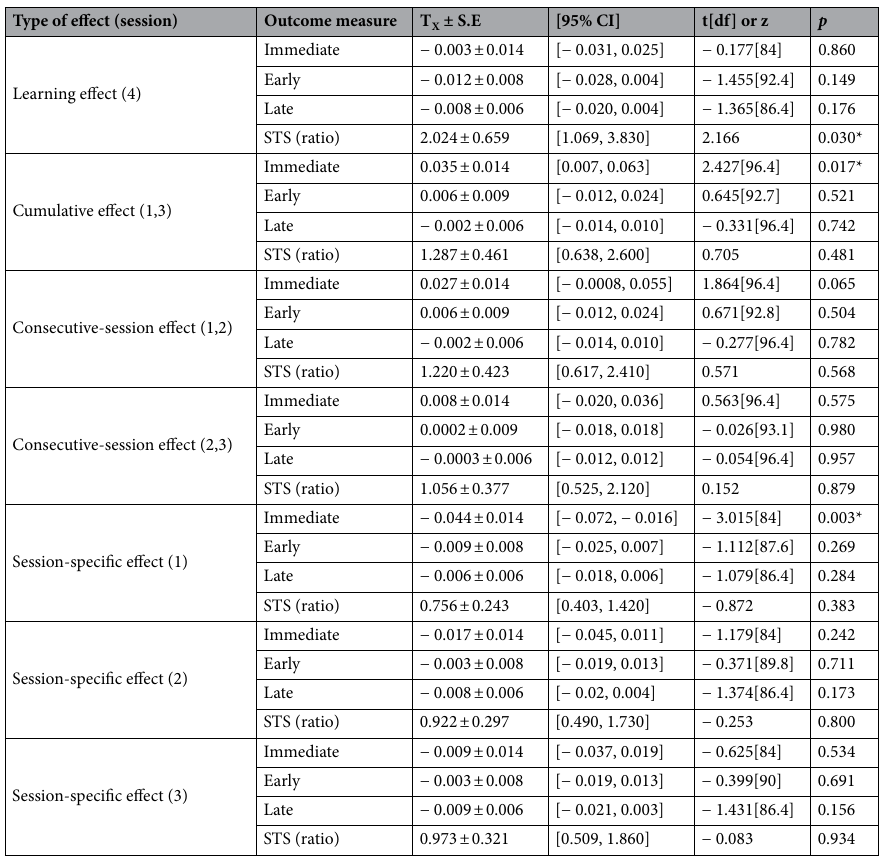
Table 2. Contrast estimates based on marginal means for the de-adaptation phase treatment effects with the standard errors estimated from the statistical models. STS strides to steady-state, TX treatment effect (in actual units i.e. step length symmetry for immediate, early, and late outcome measures; in ratio for strides to steady- state performance; for example, a ratio effect size of 2.02 means that the experimental group has a 102 percent higher mean value compared to the control group for strides to state-state performance). S.E. standard error, CI confidence interval, t t-statistics, df degrees of freedom, z z-statistics, p p value, * p <